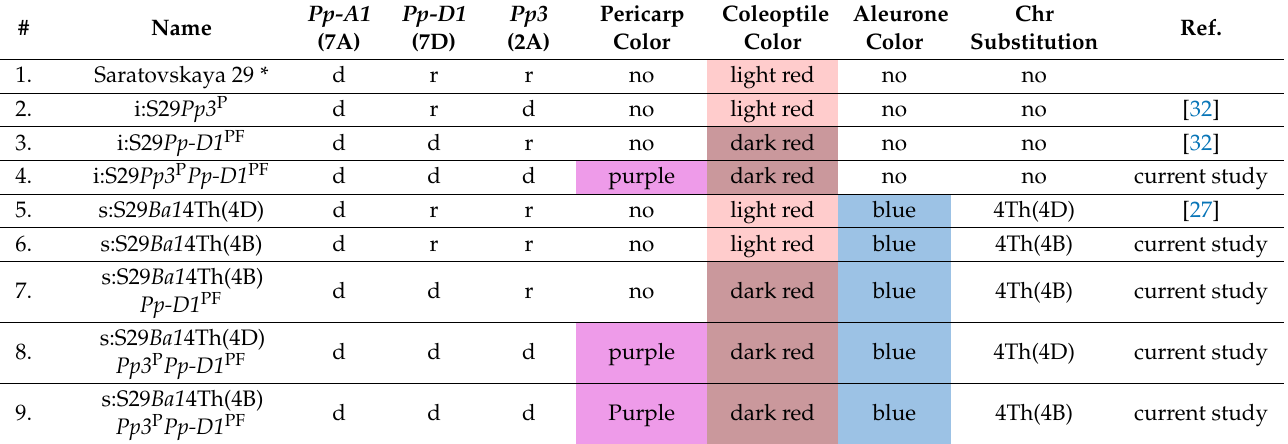
Table 2. The set of bread wheat parental and newly created lines with grain pigmentation reflecting various combinations of anthocyanin biosynthesis regulatory genes Pp-1 and Pp3 in the pericarp and Ba1 in the aleurone layer.